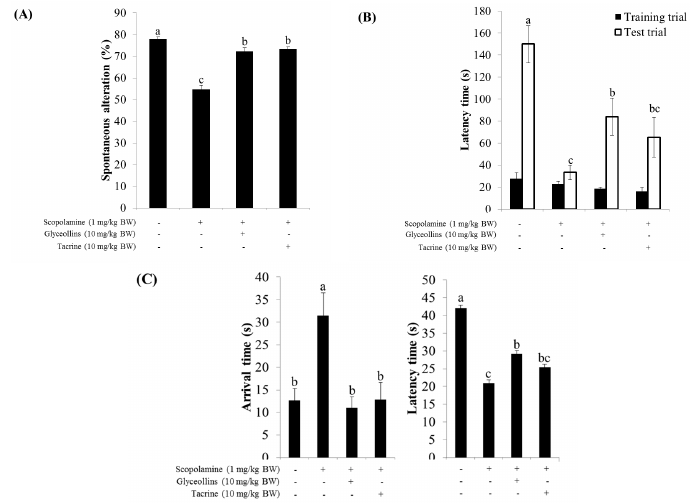
Figure 6. Effect of glyceollins on cognitive function in Nrf2 wild-type mice. Nrf2 wild-type C57BL/6 mice (five weeks old, n = 9–15) were pretreated with glyceollins (10 mg/kg bw) 24 h before cognitive function or behavior tests, and then subjected to Y-maze ( A ); passive avoidance ( B ); and Morris Water maze ( C ) tests after injected i.p . with scopolamine (1 mg/kg bw). Values are mean ± SD ( n = 9–15). Different alphabetical letters (a, b, c) indicate statistically significant differences.